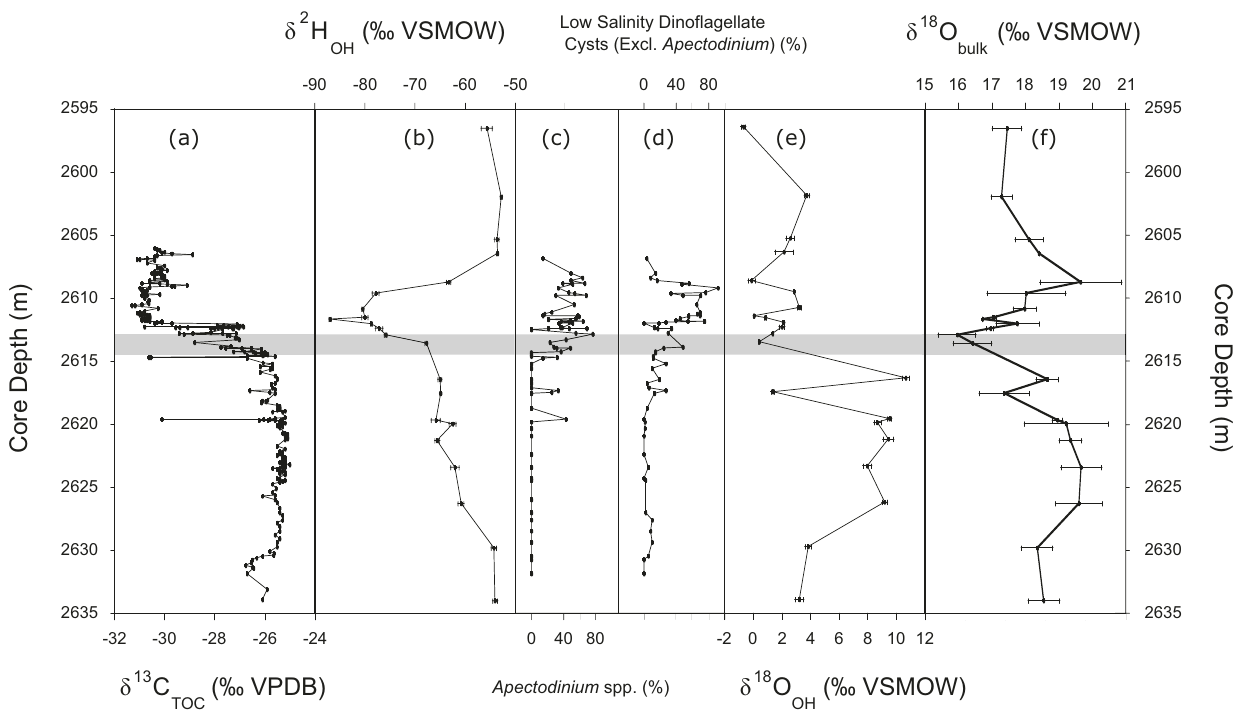
Fig. 2 | Comparison of the major trends across the onset of the Paleocene EoceneThermalMaximum(PETM)versusdepthinthecorefromwell22/10a-4. The onset of the Carbon Isotope Excursion (CIE) is shown by the light grey bar. a δ 13 C VPDB (Vienna Pee Dee Belemnite) of total organic carbon (TOC) 10 ; b clay